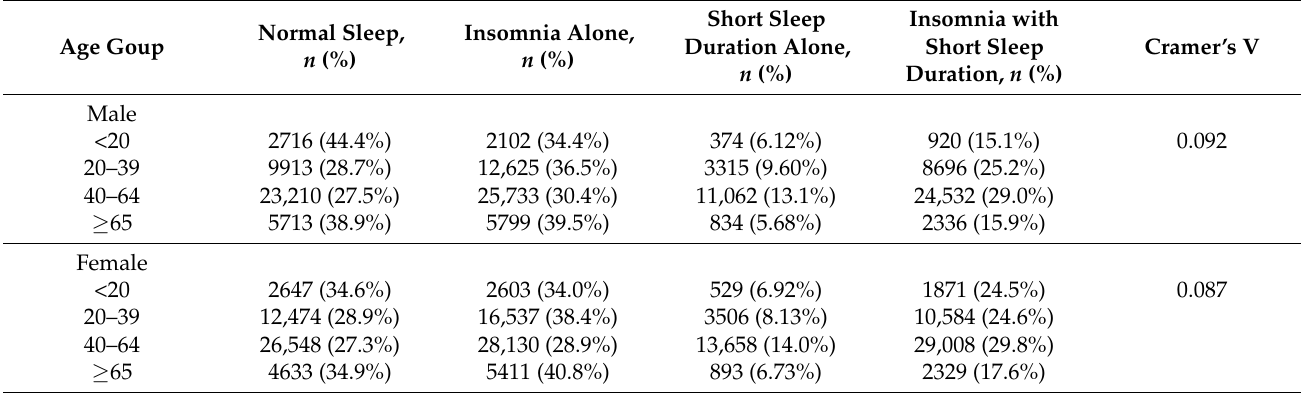
Table 3. Prevalence of insomnia/sleep duration according to the age groups.